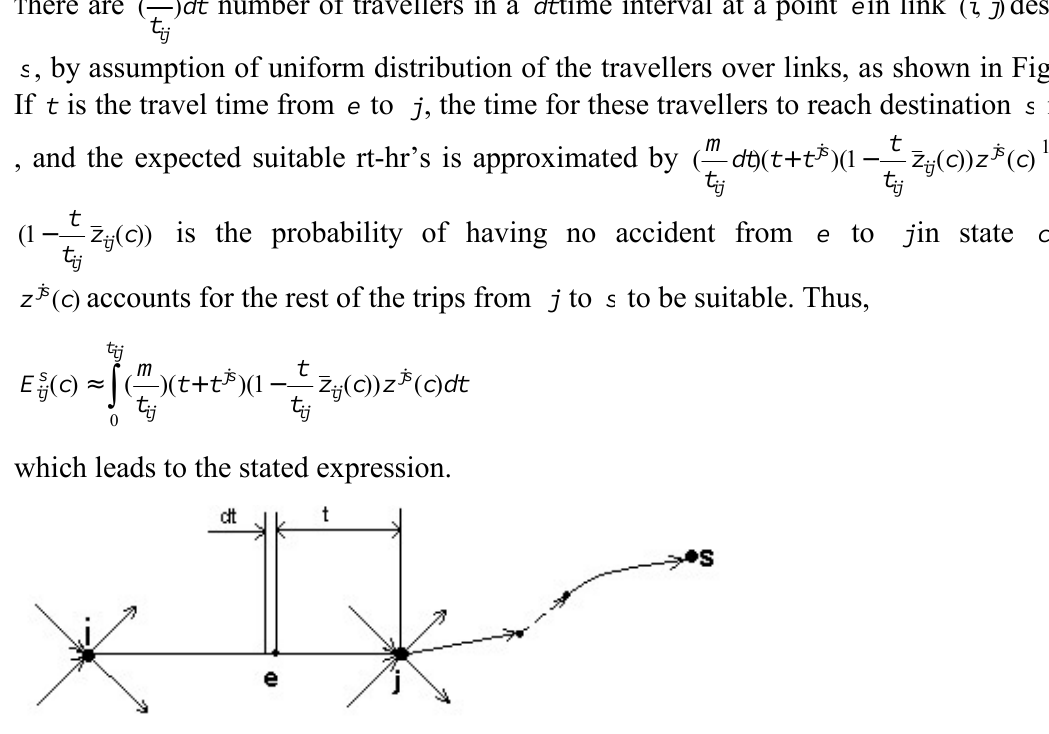
Fig.A1. Accident occurrence and determination of expected suitable